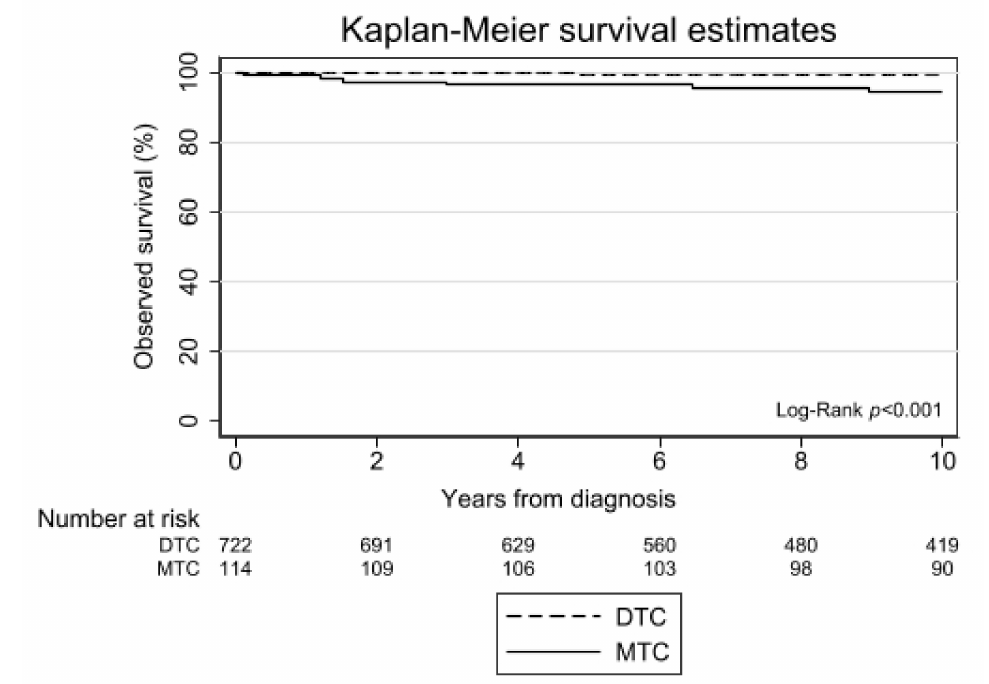
Figure 4. Observed survival of patients, aged 0–24 years with thyroid carcinoma in the Netherlands, 1990–2019. Abbrevia- tions: DTC, differentiated thyroid carcinoma; MTC, medullary thyroid carcinoma. Survival time was calculated as the time elapsed between the date of diagnosis and the date of death due to any cause (event) or censoring (i.e., loss to follow-up, emigration, or 1 February 2021), whichever came first. The log rank test showed a significantly different 10-year survival between DTC and MTC: p <